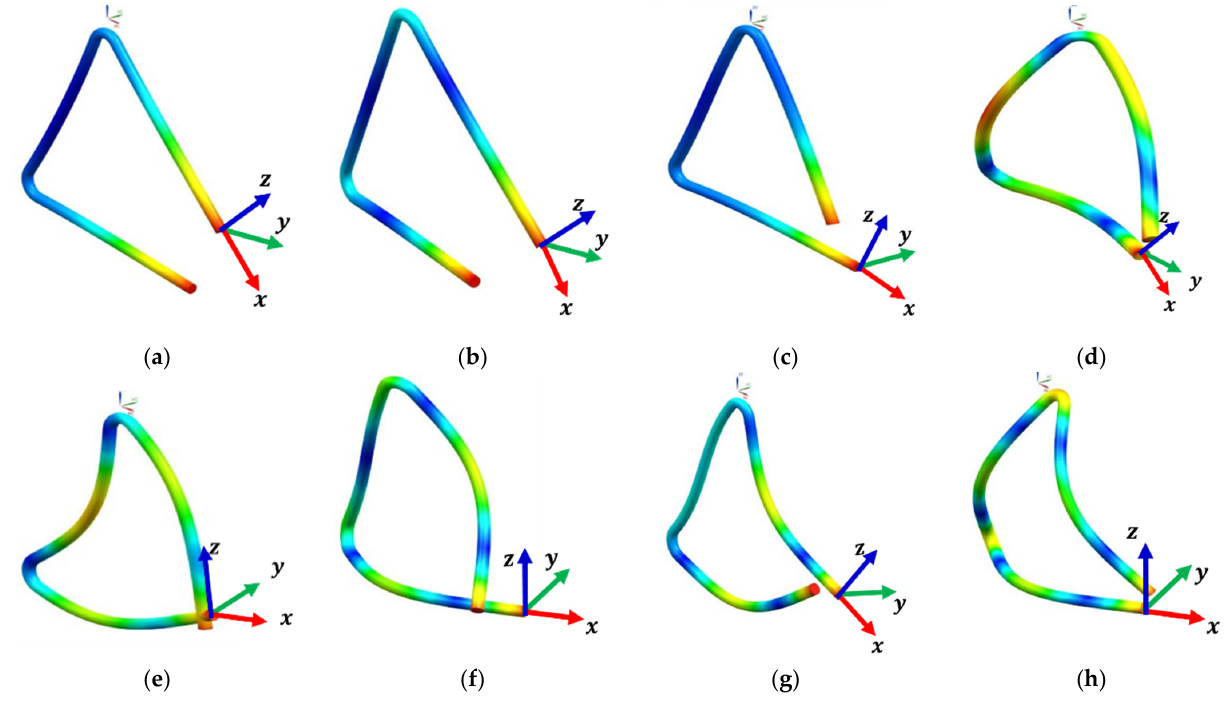
Figure 12. Vibration modes of the triangle T3: ( a ) mode 1 (97.69 Hz); ( b ) mode 2 (99.58 Hz); ( c ) mode 3 (172.4 Hz); ( d ) mode 4 (519.67 Hz); ( e ) mode 5 (622.26 Hz); ( f ) mode 6 (912.36 Hz); ( g ) mode 7 (932.88 Hz); ( h ) mode 8 (1050.32 Hz).